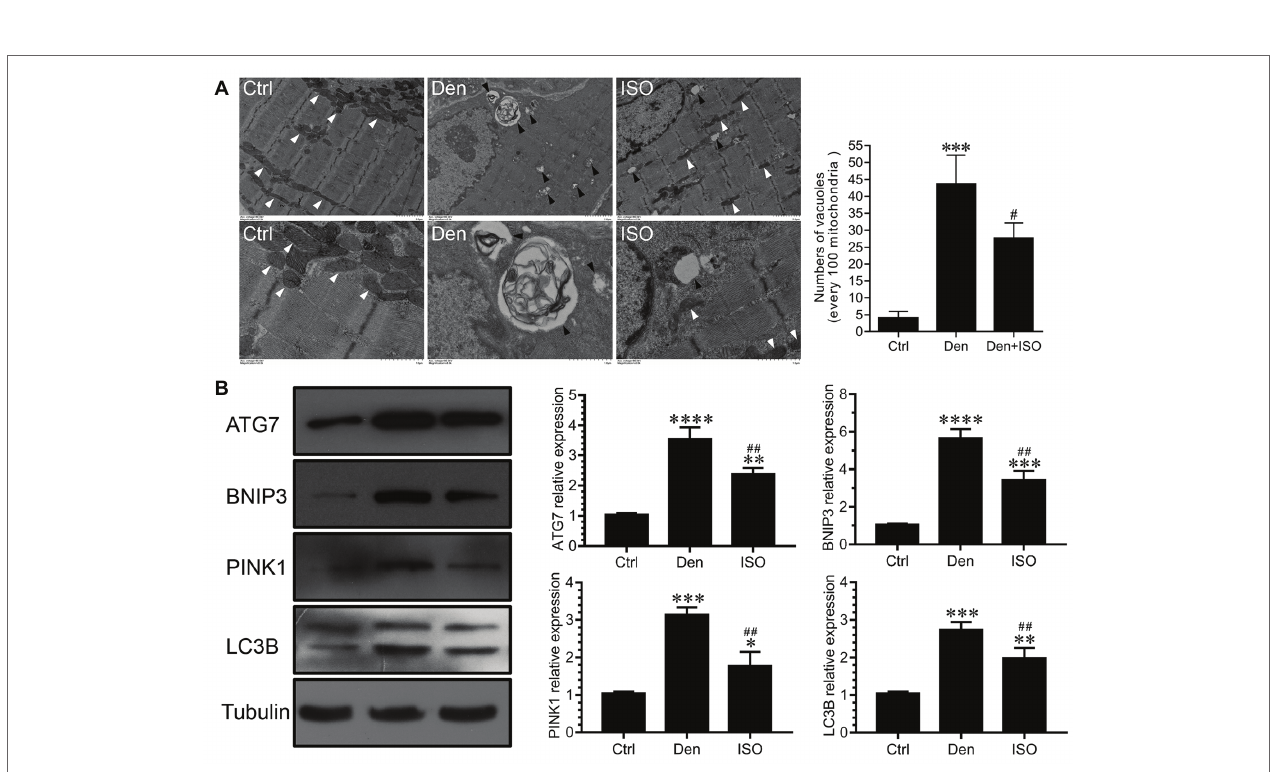
FIGURE 3 | Isoquercitrin reduces mitochondrial autophagy in denervated soleus muscles. (A) Ultrastructure of muscle fibers observed using transmission electron microscopy ( n = 3). The white arrow indicates mitochondria between muscle fibers. The black arrow indicates an autophage or an autophagic vesicle. (B) Western blot and quantification of the autophagy-related proteins ATG7, BNIP3, PINK1, and LC3B ( n = 6). Ctrl, control group; Den, denervation group; ISO, denervated target muscle plus isoquercitrin (20 mg/kg/d) group. * p < 0.05, ** p < 0.01, *** p < 0.001, and **** p < 0.0001 vs. Ctrl; # p < 0.05 and ## p < 0.01 vs. Den.